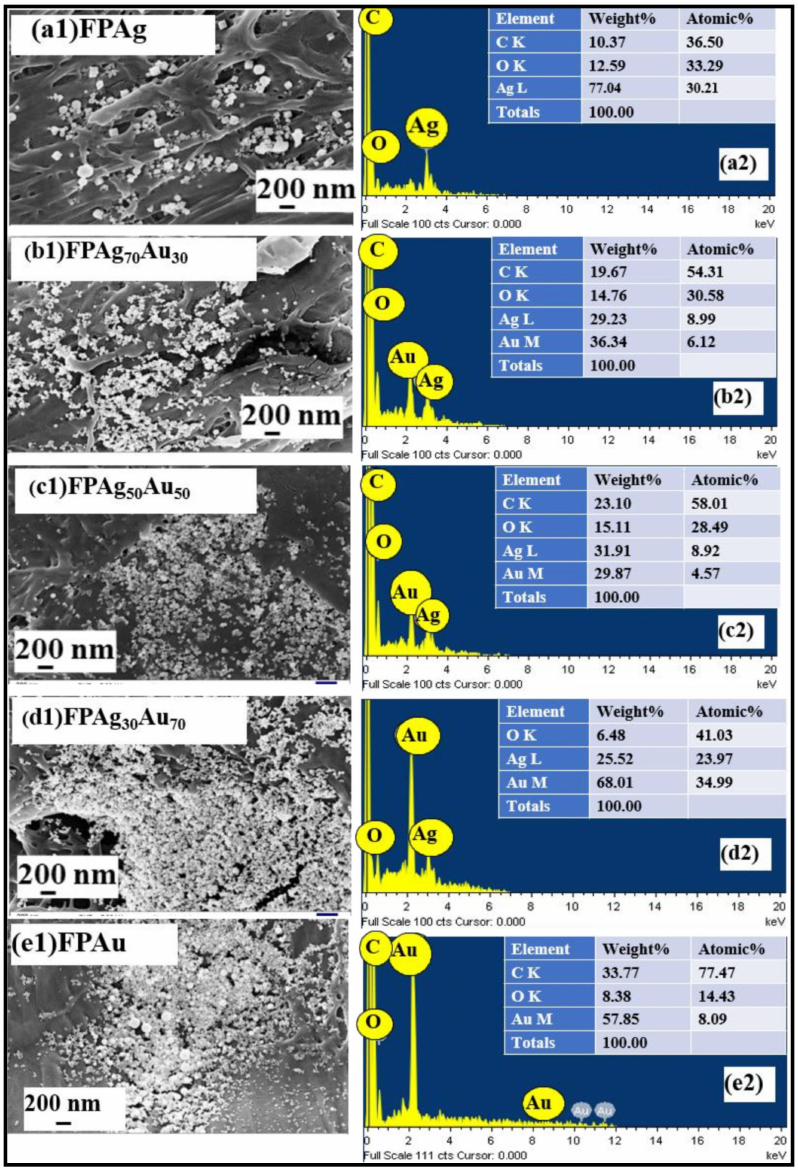
Figure 4. FESEM images of filter paper-loaded pure and alloy NPs and their corresponding EDX spectra of ( a1 , a2 ) Pure Ag, ( b1 , b2 ) Ag 70 Au 30 , ( c1 , c2 ) Au 50 Ag 50 , ( d1 , d2 ) Ag 30 Au 70 , and ( e1 , e2 ) Pure Au,